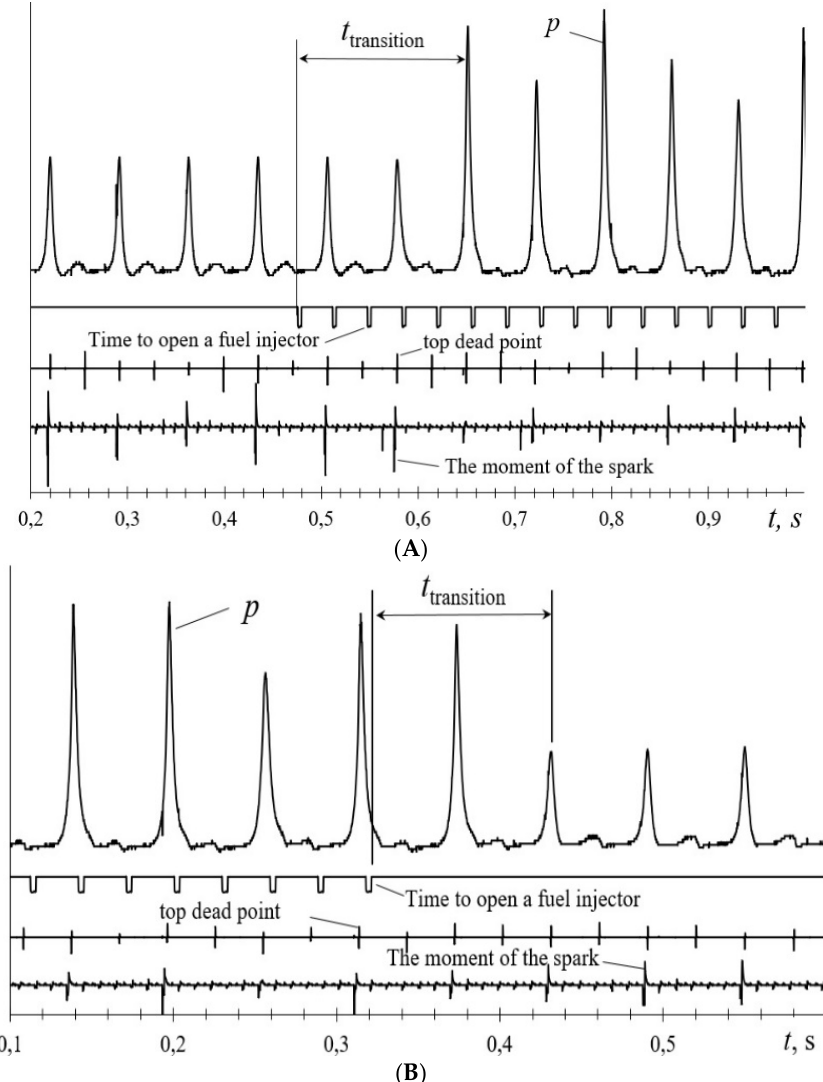
Figure 11. Fragments of oscillograms of the transition process of the Opel C30 LE engine when: ( A ) fuel is supplied to the cylinder, and ( B ) fuel is not supplied to the cylinder.